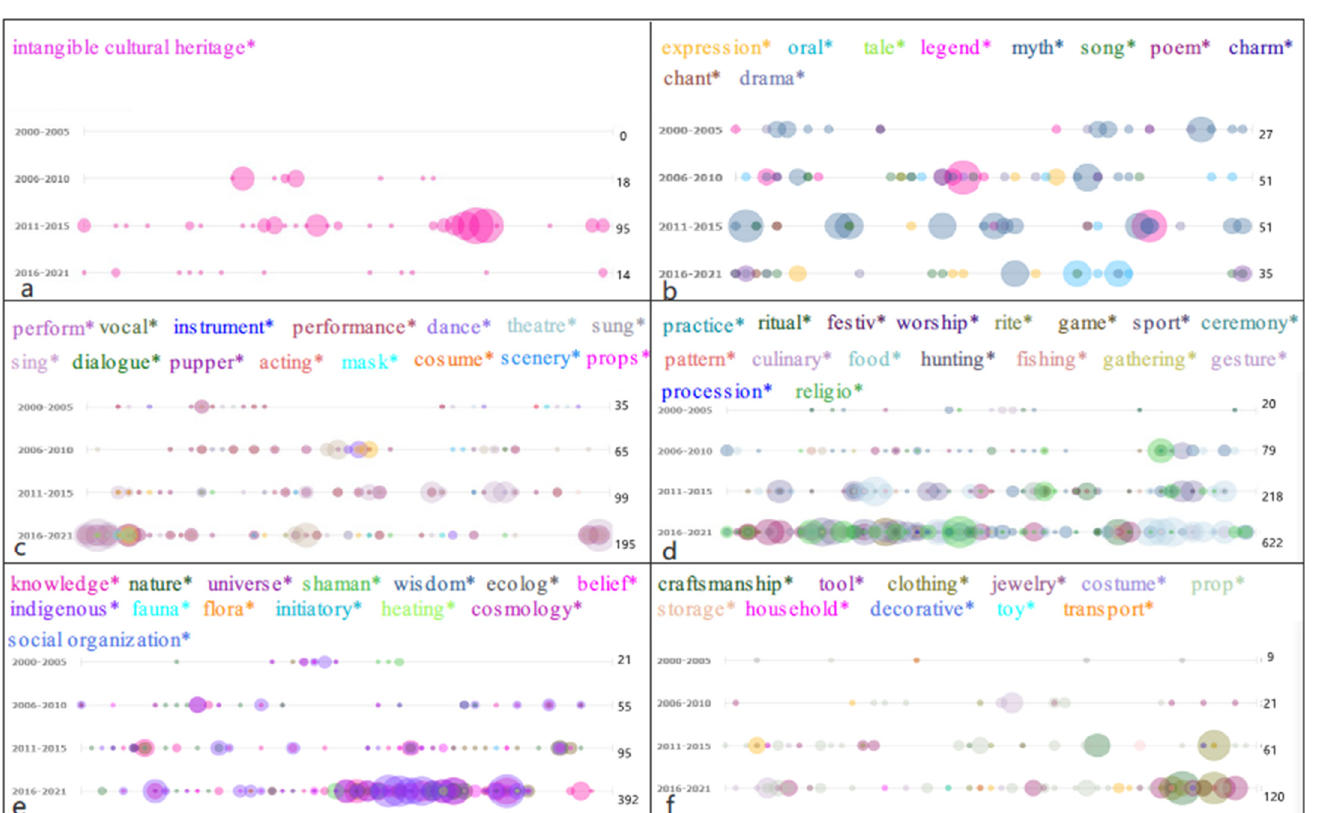
Figure 5. ( a ) Bubblelines of terms in the category “Intangible cultural heritage”. ( b ) Bubblelines of terms in the category “Oral traditions and expressions”. ( c ) Bubblelines of terms in the category “Performing arts”. ( d ) Bubblelines of terms in the category “Social practices, rituals and festive events”. ( e ) Bubblelines of terms in the category “Knowledge and practices concerning nature and the universe”. ( f ) Bubblelines of terms in the category “Traditional craftsmanship”. Note: * means match terms that start with this word as one term. Source: edited by authors based on research and Voyant Tools